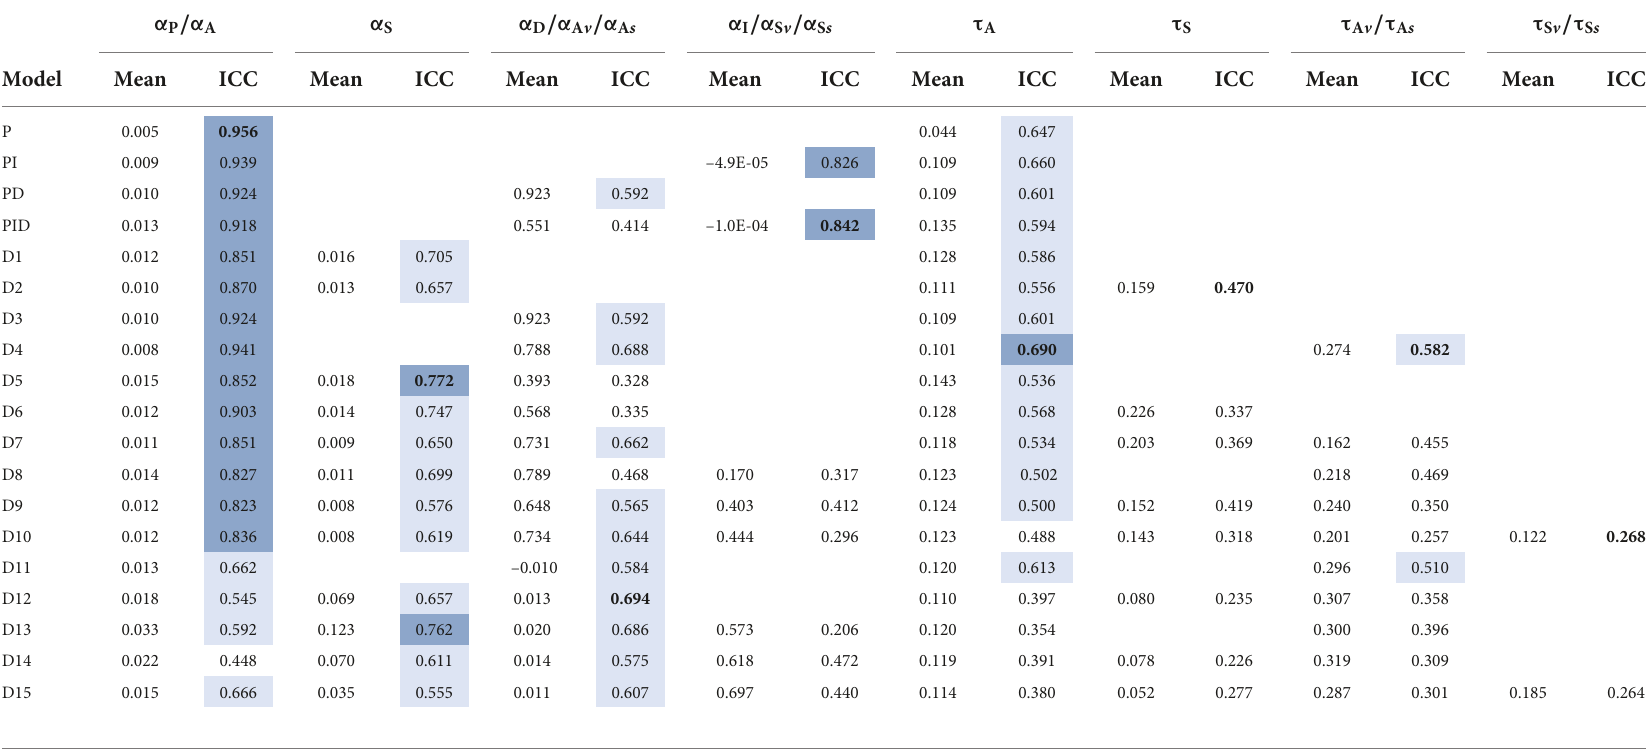
TABLE 3 Study 1 mean values and ICC of optimized parameters in cross-validation